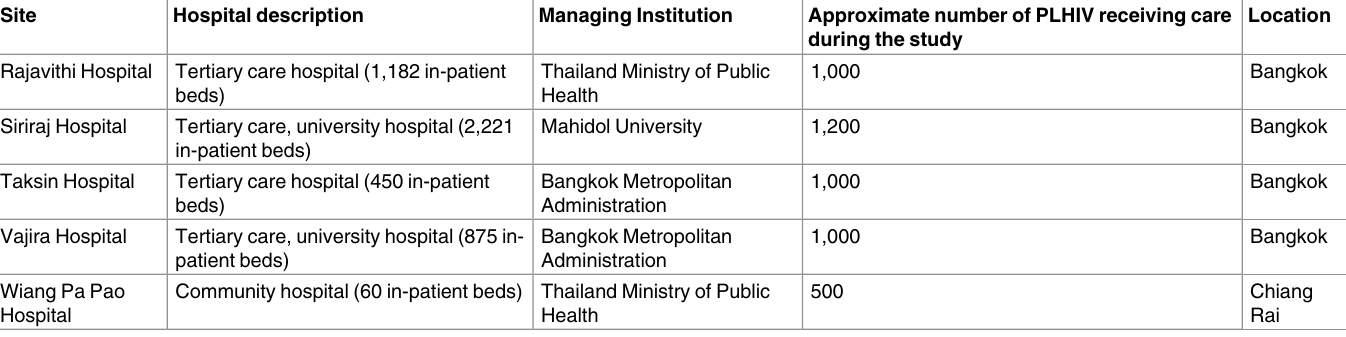
Table 1. Characteristics of hospitals participating in prevention with positives intervention assessment,Thailand,